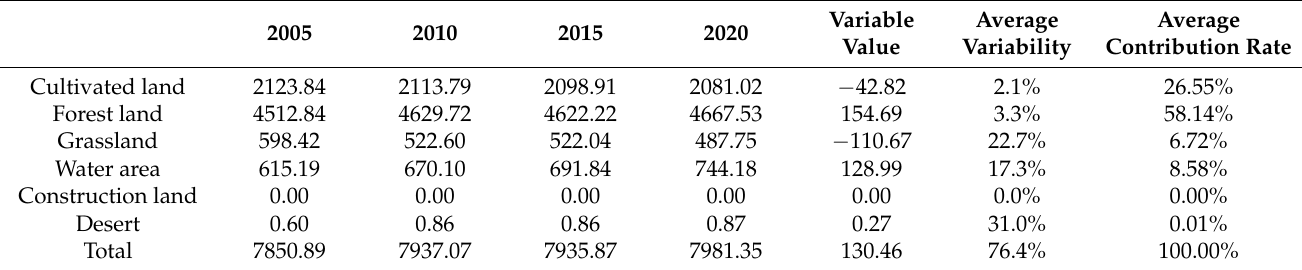
Table 4. Value of services and their changes by ecosystem type, 2005–2020 (unit: billion).